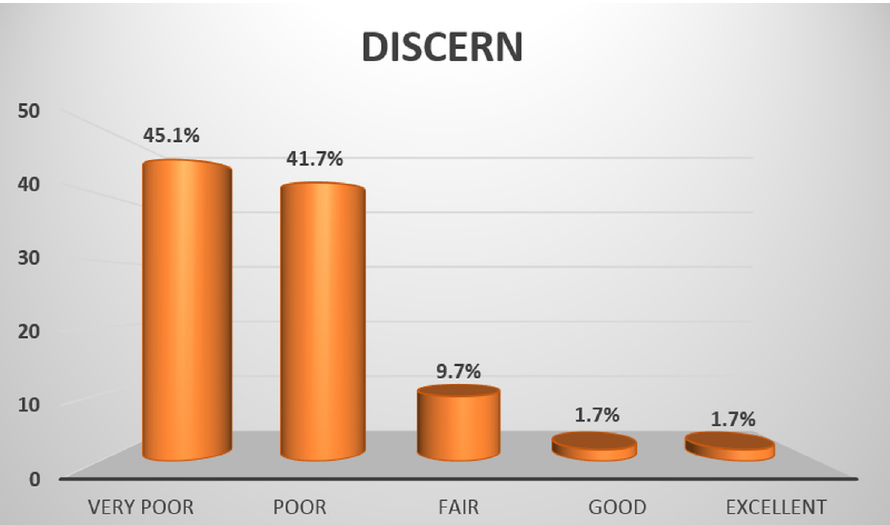
Figure 3. % distribution DISCERN scores of all analysed